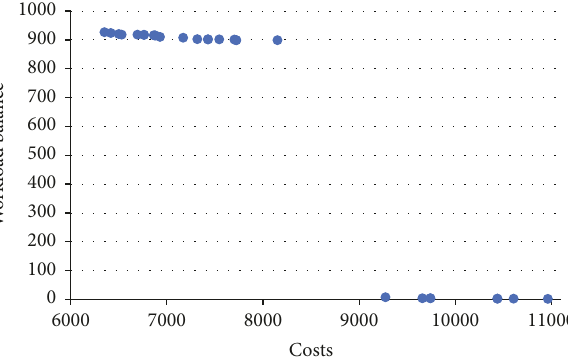
Figure 4: Approximation of the Pareto front of Instance 3.